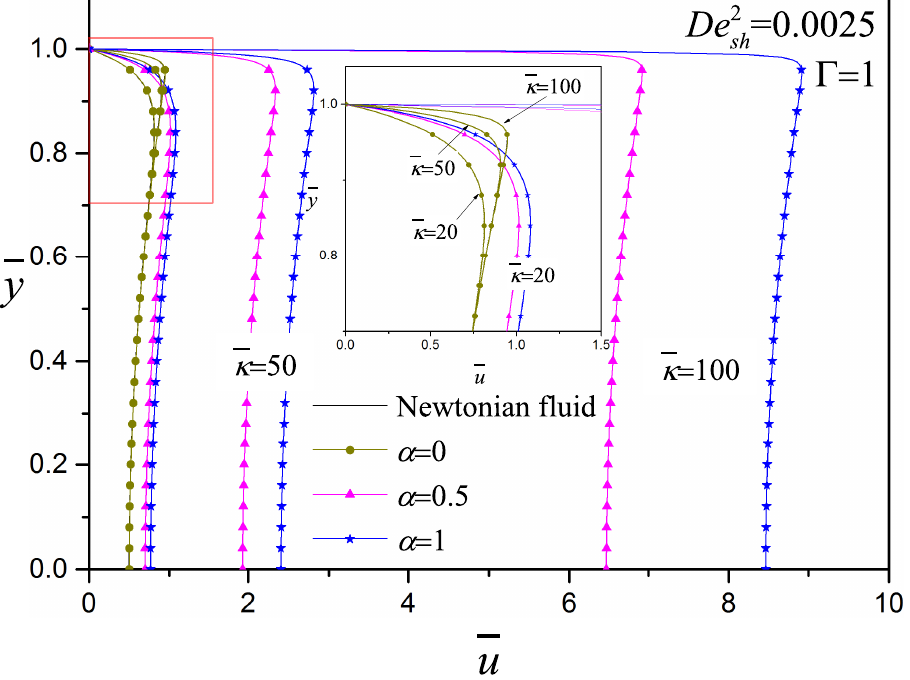
= 0.0025 and Γ = 1 for the sh